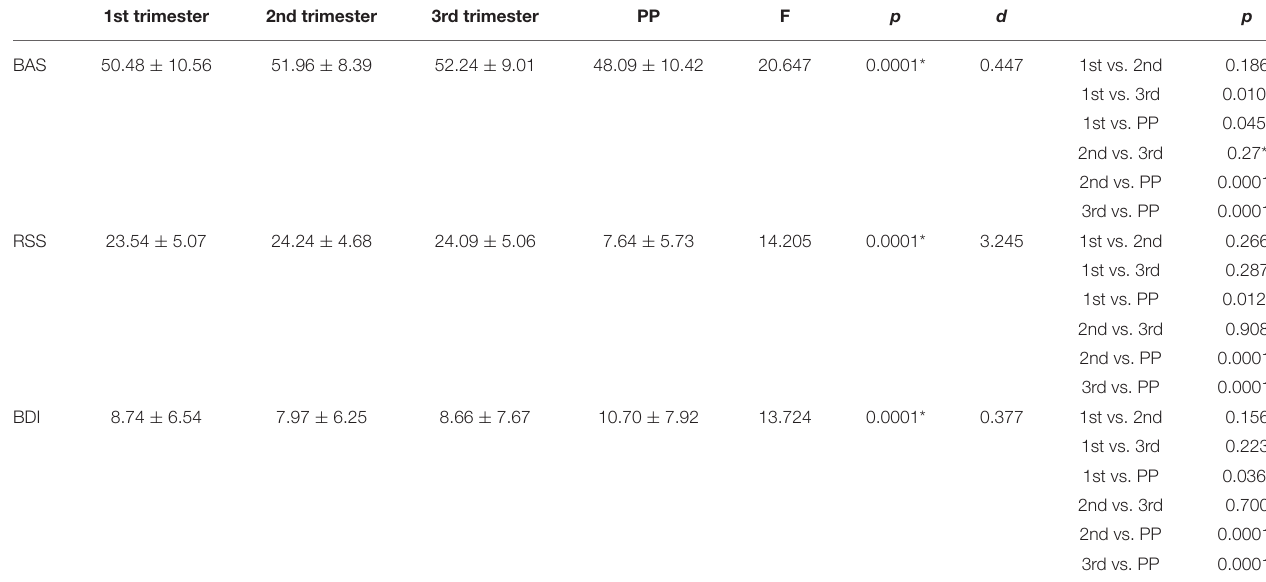
TABLE 3 | Covariance analyses of body appreciation, depression symptoms, and self-esteem between the perinatal period adjusting covariates for each variable. 1st trimester 2nd trimester 3rd trimester PP F p